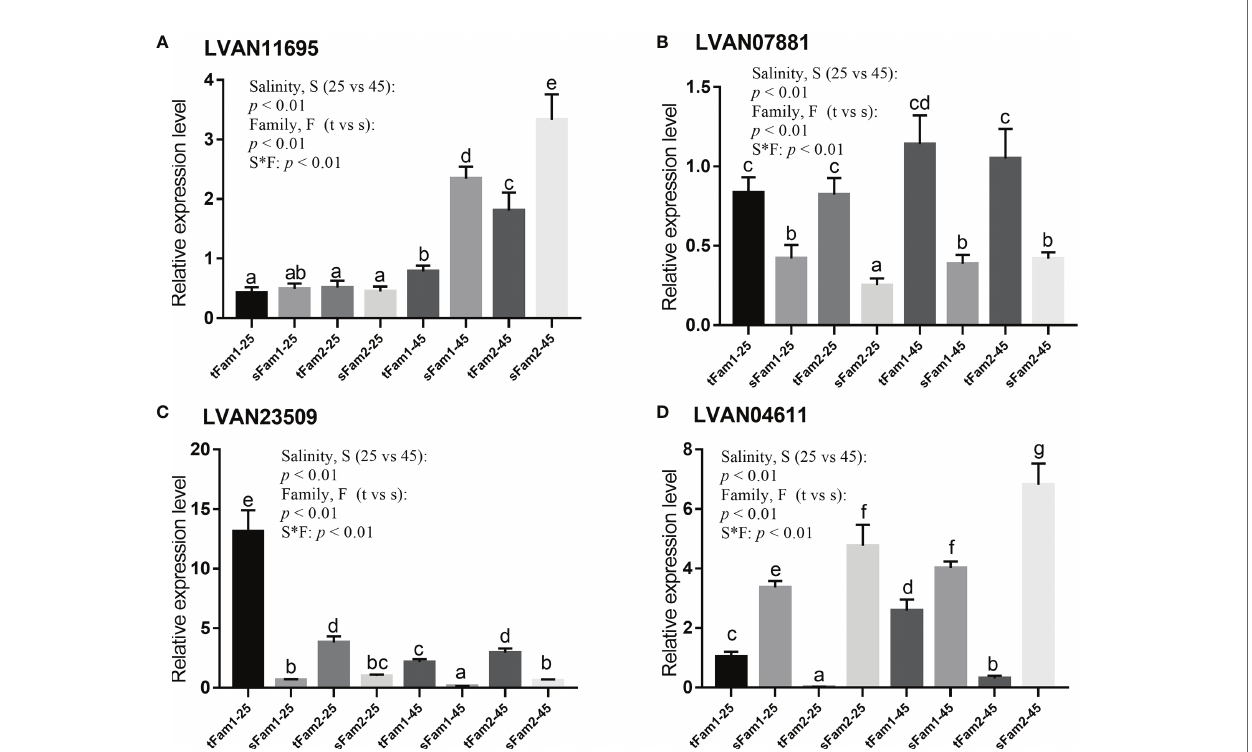
FIGURE 6 | Comparison of the relative expression levels of four DEGs between tolerant families and susceptible families under salinity of 25 and 45 ppt detected by qPCR. Two-way ANOVA (factor: salinity and family) analysis was utilized to determine the statistical differences, and one-way ANOVA was used to reveal the signi fi cant differences among different samples, p represents the p-value of two-way ANOVA, S*F represents the interaction between salinity and family, t represents tolerant family, and s represents susceptible family. Columns with the same letters show no signi fi cant difference, while columns with different letters indicate signi fi cant differences. (A) LVAN11695: betaine – homocysteine S-methyltransferase, (B) LVAN07881: actin, alpha skeletal muscle, (C) LVAN23509: crustacyanin subunit C, and (D) LVAN04611: triose-phosphate isomerase. DEGs, differentially expressed